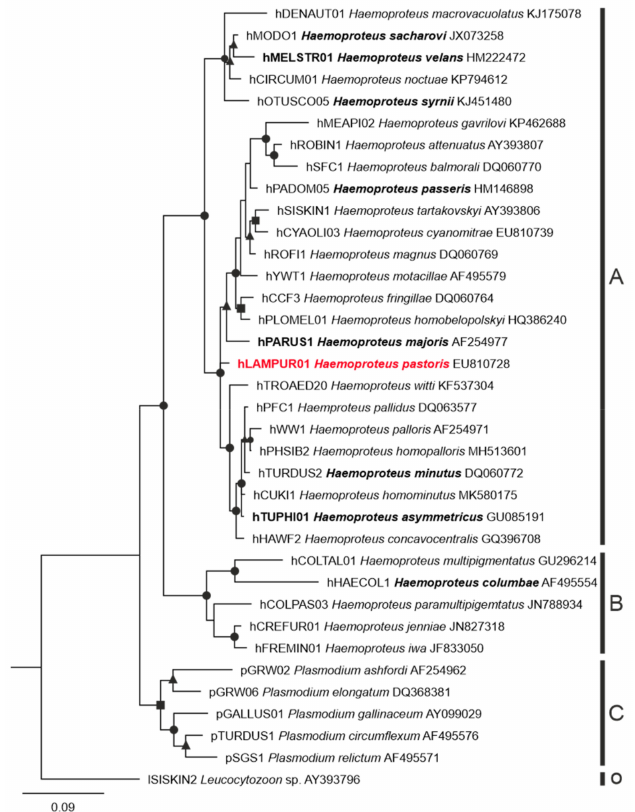
Figure 2. Bayesian phylogenetic tree of partial cytochrome b sequences of 30 lineages of Haemoproteus parasites, 6 lineages of Plasmodium spp., and 1 Leucocytozoon sp. lineage used as an outgroup. Vertical bars (A-O) represent parasite species of the subgenera Parahaemoproteus ( A ), Haemoproteus ( B ),